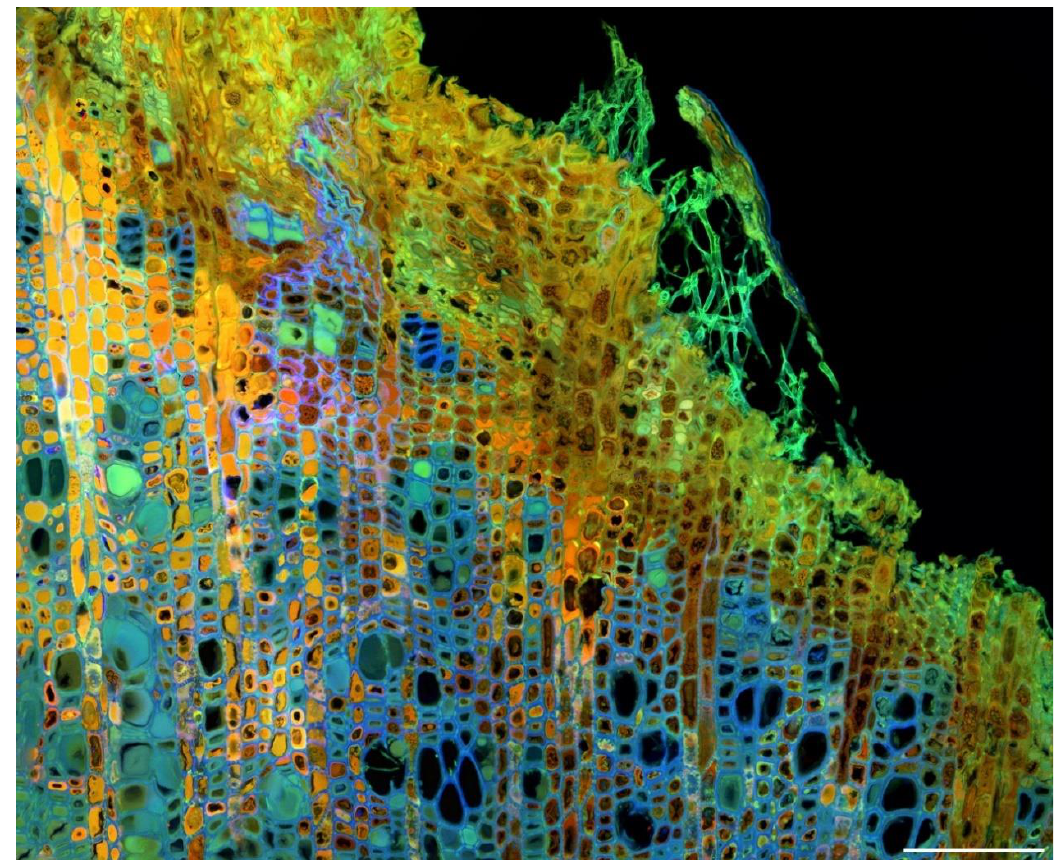
Figure 11. Spectral imaging of autofluorescence in a diseased apple stem ( Nectria canker) using sequential excitation with emission ranges centered around the λ max for each excitation wavelength. Excitation at 355 nm (UV), 488 nm (blue), and 561 nm (green). Many different unidentified fluorophores are present. However, blue cell walls represent lignin. Scale bar = 100 µm.